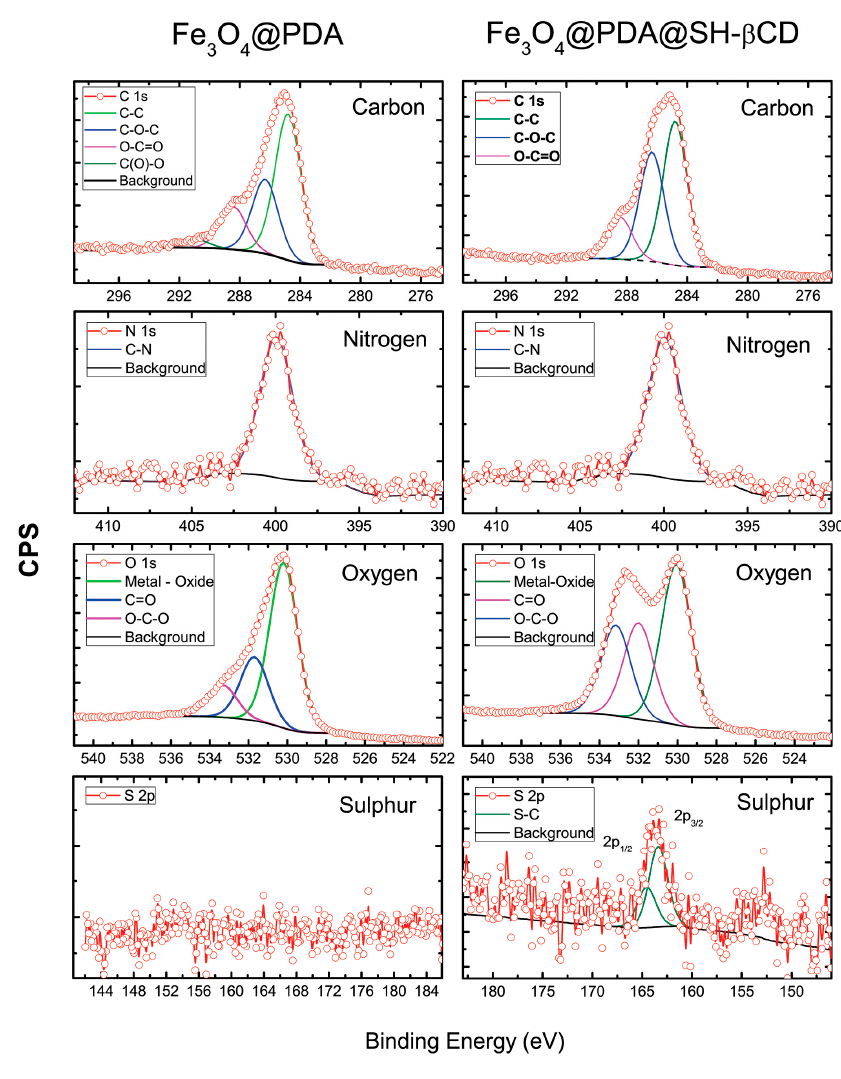
Figure 2. High-resolution XPS spectra for Fe 3 O 4 @PDA (sample A) and after functionalization with SH- β CD (Sample B).